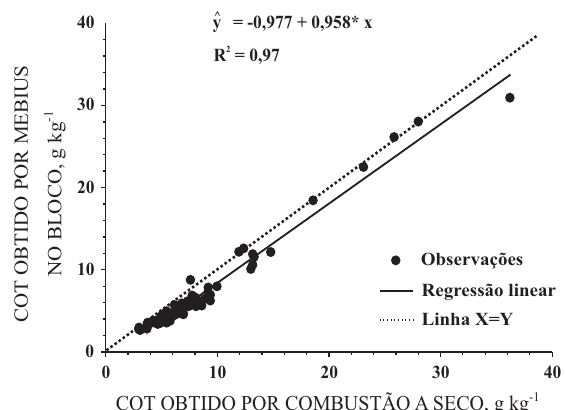
Figura 1. Regressão linear entre os teores de C orgânico total (COT) de um Argissolo Vermelho- Amarelo distrófico abrúptico estimados pelos métodos da combustão a seco e Mebius no bloco, Santa Maria, RS,